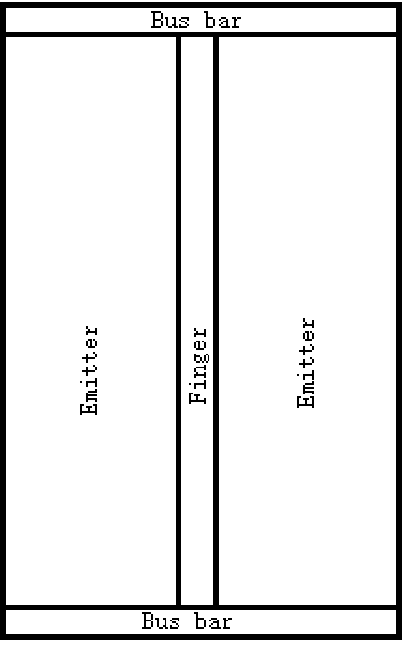
Figure 1. PV cell model